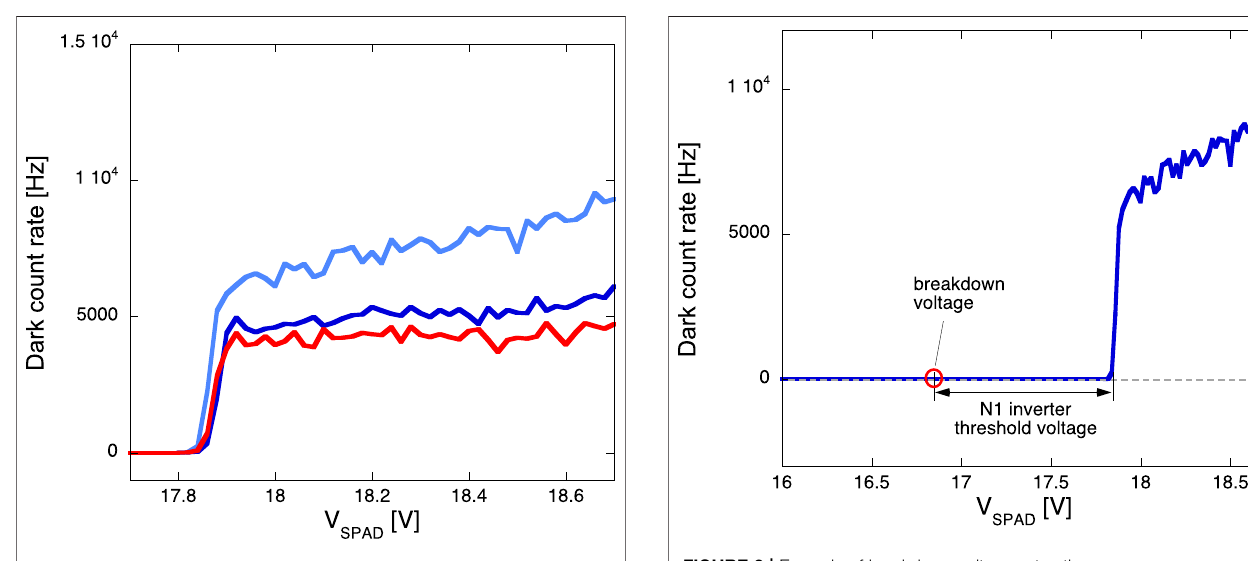
FIGURE 7 | Dark count rate as a function of the voltage applied to the SPAD cathode for three different pixels from the a -1 array in a FATHER chip (FATHER1).